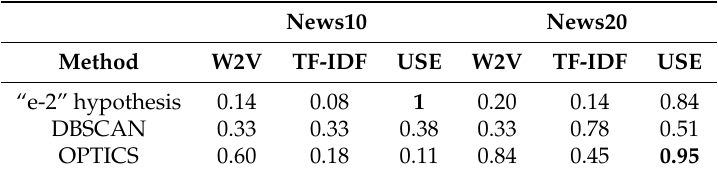
Table 8. The number of clusters’ inference accuracy for News10 and News20.